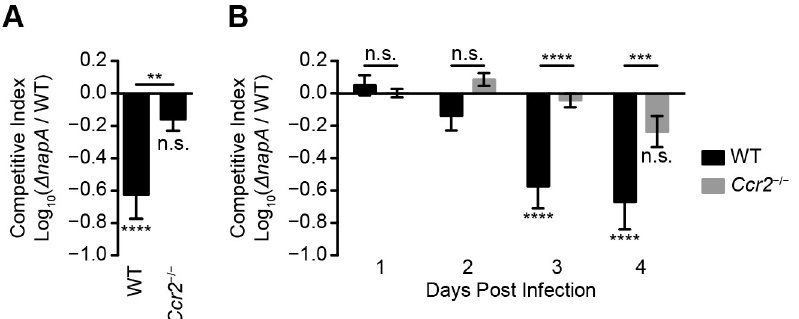
Fig 5. IM contribute to the generation of host-derived nitrate used by STm for growth in the lumen of the inflamed intestine. (A-B) Competitive indices of WT and napA mutant STm CFU in cecal contents (A) and fecal pellets (B) from C57BL/6J (WT) and Ccr2 -/- mice (n = 16 per group) treated with Sm prior to inoculation with a 1:1 mixture of differentially marked WT and napA mutant STm. Cecal contents were collected on day 4 after inoculation. Fecal pellets were collected daily up to day 4 after inoculation. Competitive indices were calculated by dividing the number of napA mutant STm CFU by the number of WT STm CFU, and normalized to the input ratio. Data show mean with SEM from three independent experiments and were analyzed by one-way ANOVA (A) or two-way ANOVA (B) with Sidak post hoc